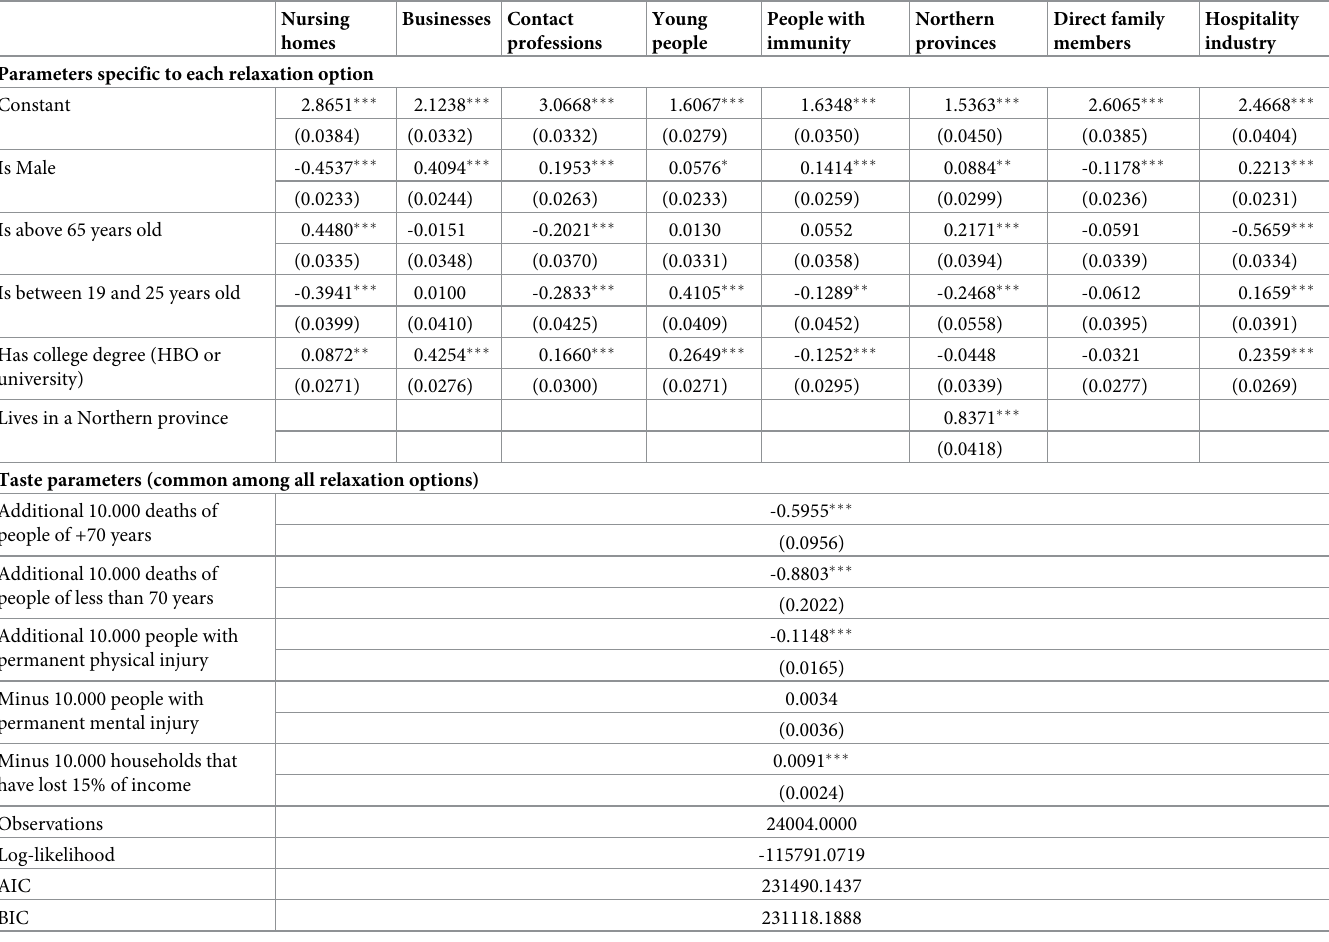
Table 3. Estimation results of MDCEV-PVE model (with